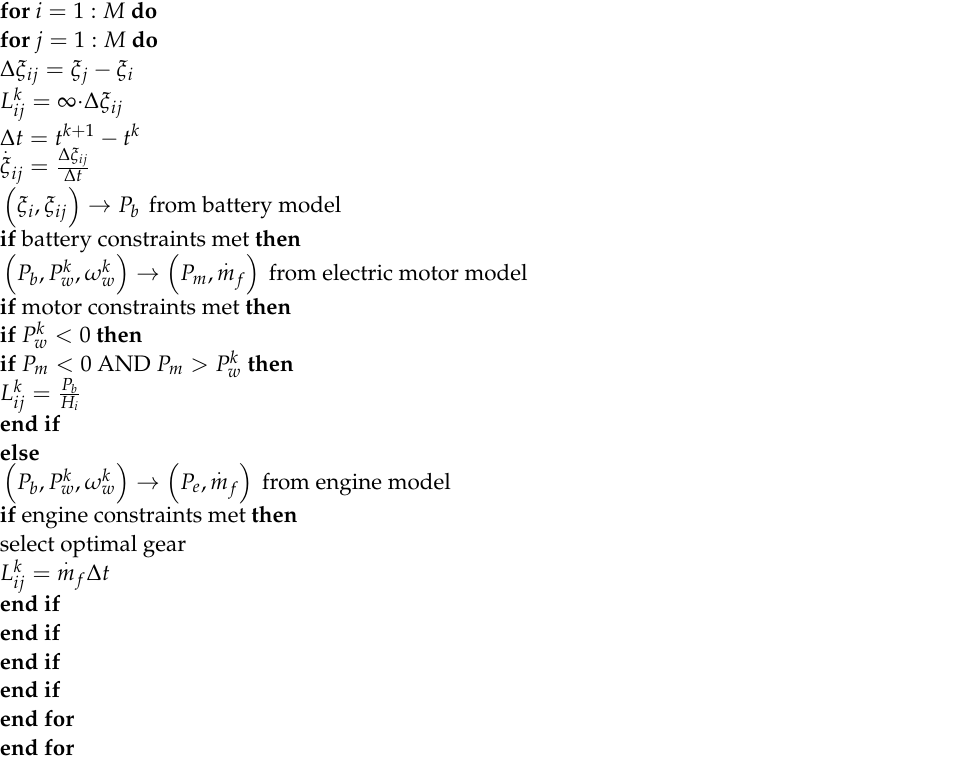
Algorithm A2 Calculation of the transition cost for the HEV optimal control